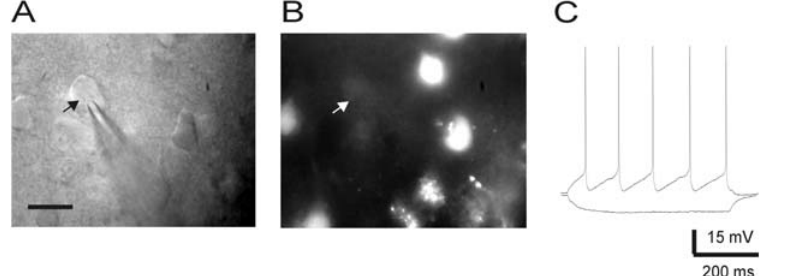
Figure 7. Pyramidal neurons do not exhibit DAF-2DA fluorescence. (A) IR/DIC image of a recorded pyramidal neuron (arrow) and the patch pipette. Scale bar=25 m m. (B) Fluorescence image of the recording region, revealing fluorescent cells other than the recorded one. The arrow marks the location of the recorded neurons as in (A). (C) Example traces from the recorded neuron in response to injected current pulses. The firing pattern is typical of a regular-spiking pyramidal neuron.